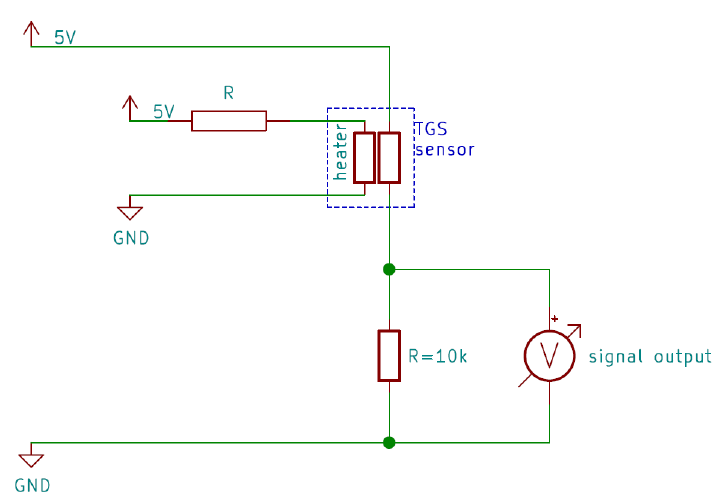
Figure 3. The scheme of wiring for a representative sensor. There was an additional resistor, allowing us to modify the electric voltage applied to the sensor’s heater and thus reduce the sensing element’s temperature. Table 2. Resistors connected to each sensor’s heater supply circuit and the electric voltage applied to each sensor’s heater, in the PW6 electronic